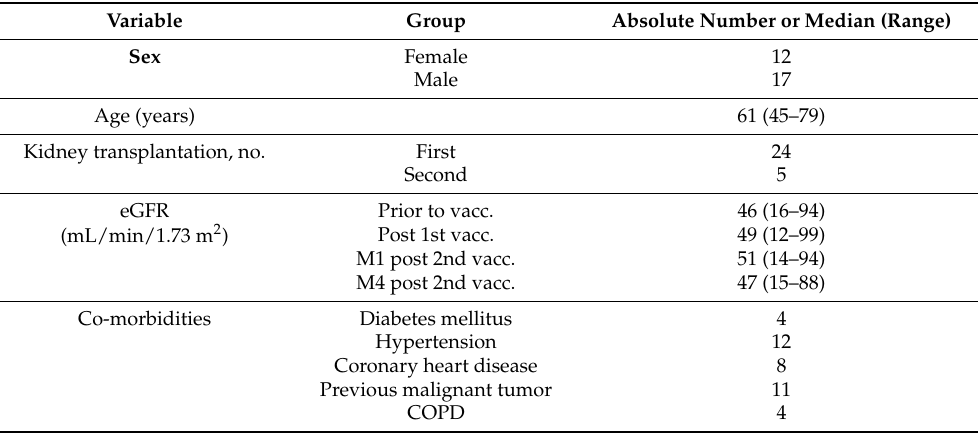
Table 2. Characteristics of the 29 kidney transplant recipients tested prior to and post vaccination with